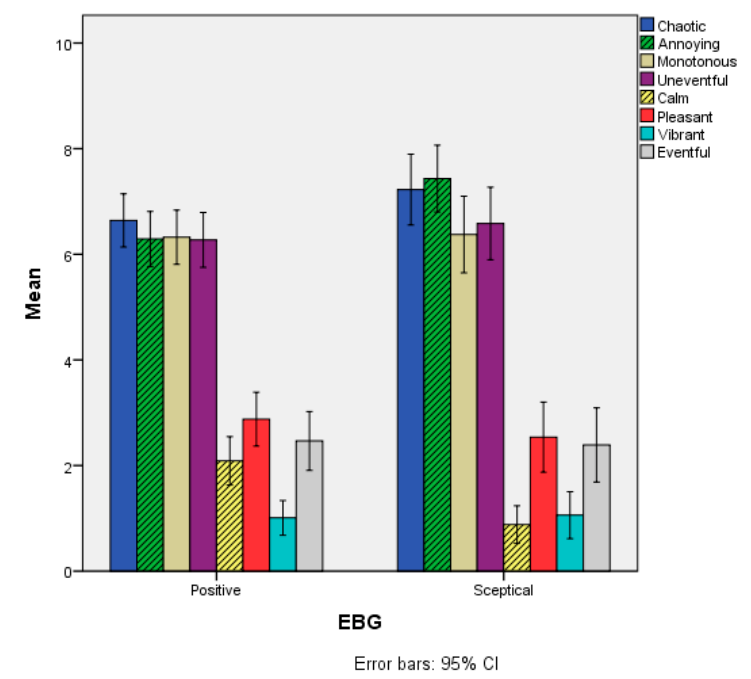
Figure 9. Mean scores of the Soundscape appraisal items as a function of the EBG variable. Grey-shaded bars refer to items where statistically significant differences were observed between the two groups.